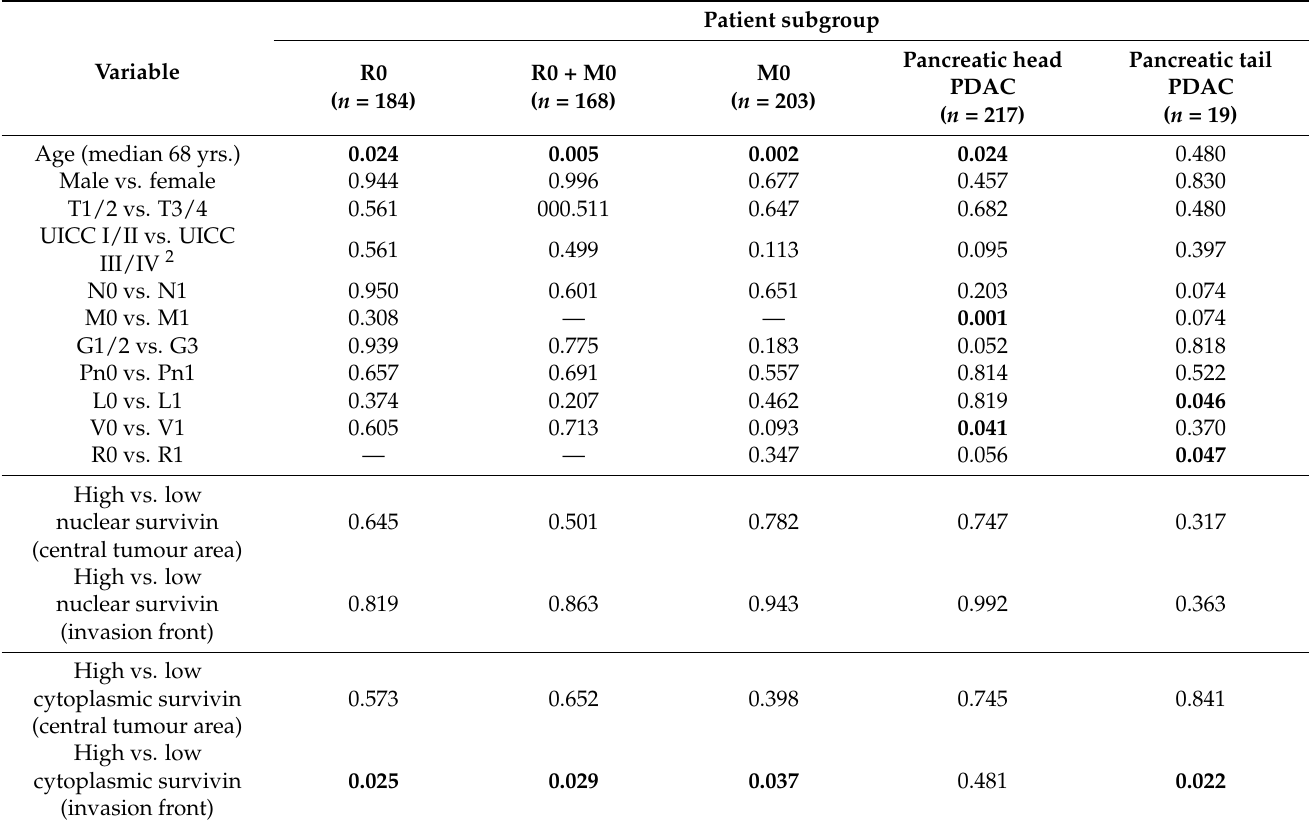
Table 5. Univariate subgroup analysis for overall survival 1